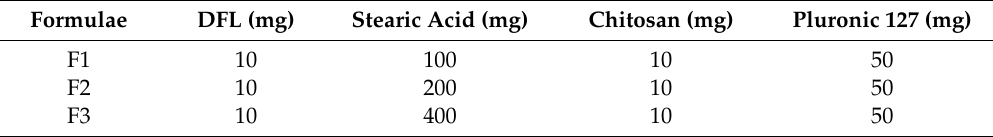
Table 1. Composition of delafloxacin (DFL)-loaded stearic acid (lipid) chitosan (polymer) hybrid nanoparticles